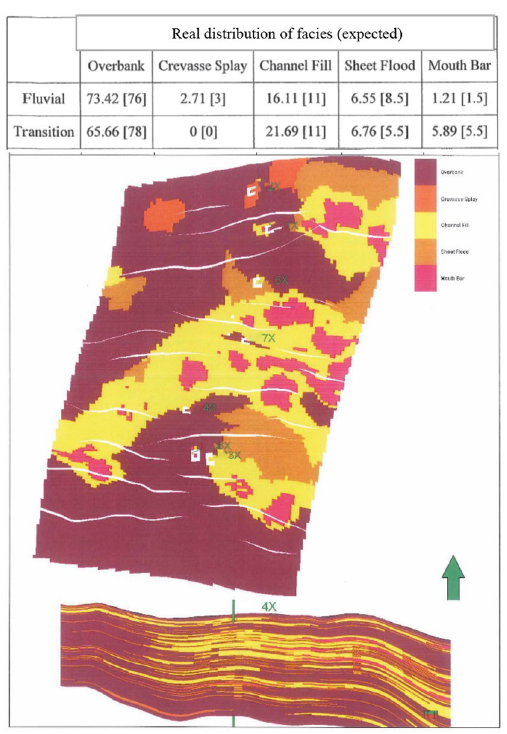
Fig. 25 Resulting model of case R1_2